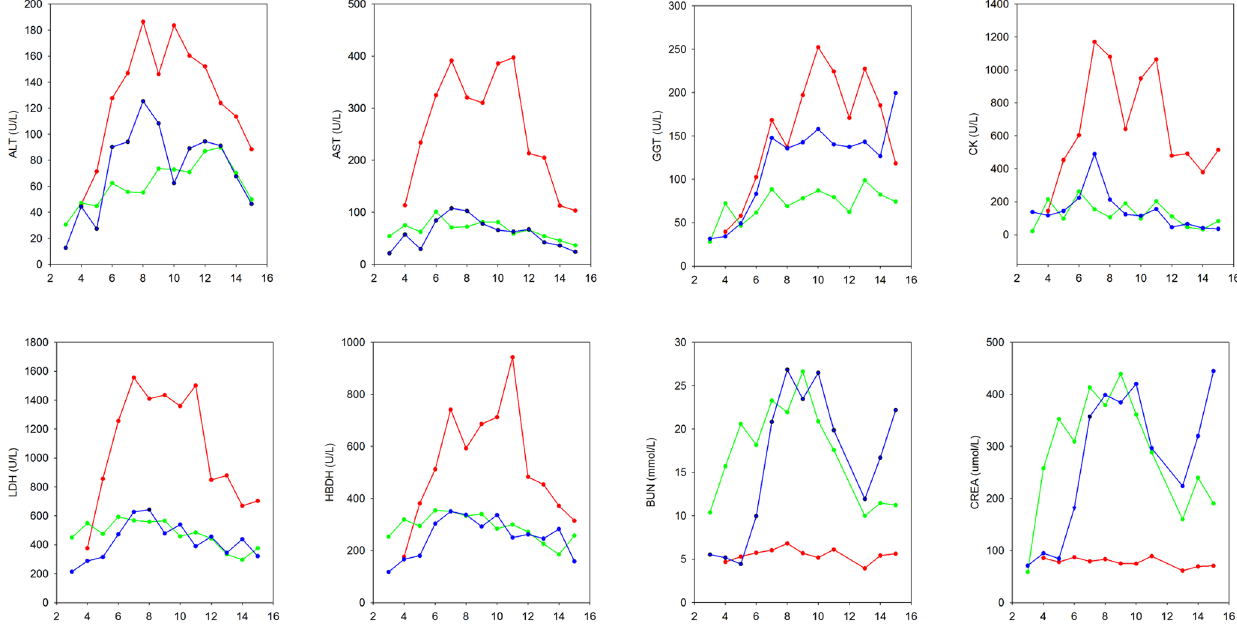
Figure 4. Changes in alanine aminotransferase (ALT), aspartate aminotransferase (AST), gamma-glutamyl transferase (GGT), creatine kinase (CK), lactate dehydrogenase (LDH), hydroxyhutyrate dehydrogenase (HBDH), blood urea nitrogen (BUN), and creatinine (CREA) levels in patients with HYSHF, HFRS, and undetermined infections. The color coding is the same as in Figure 3. More details are given in Table